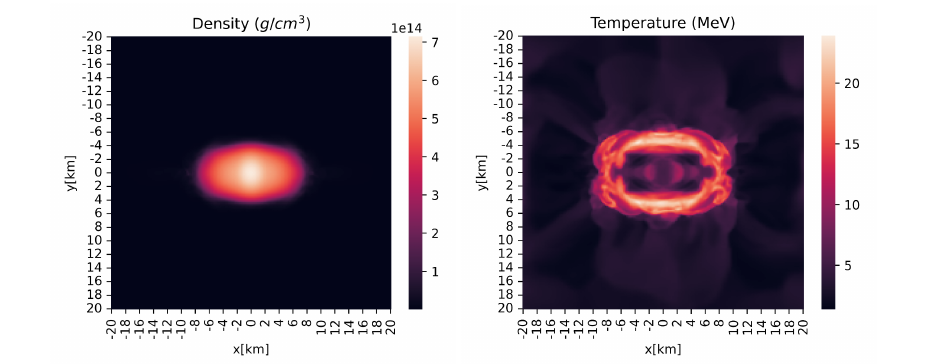
Figure 1: The left panel shows our density profile in g / cm 3 , and the right panel shows the temperature profile in